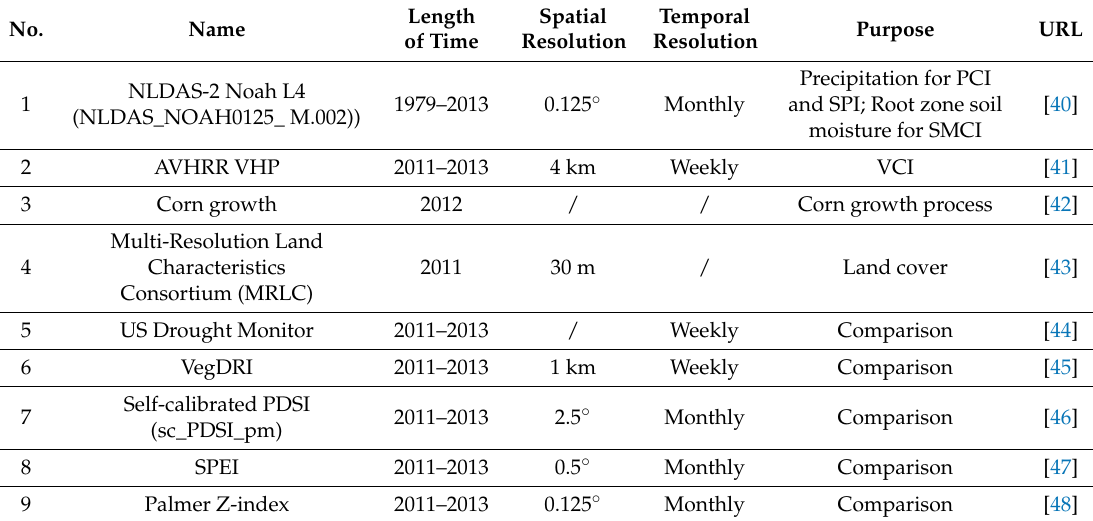
Table 1. Datasets used in this study.